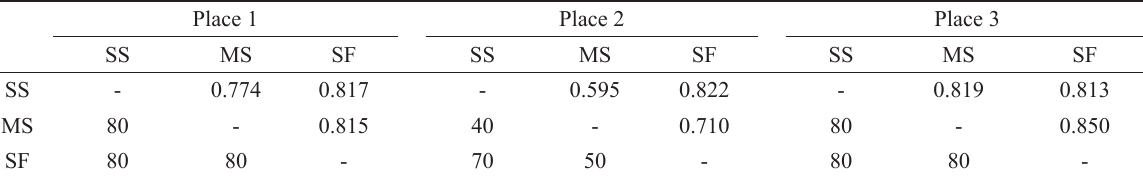
Spearman correlation (above the diagonal) and percentage of coincidence of the top ten families (below the diagonal) between the genetic values of the traits spawning success (SS), multiple spawning (MS) and spawning frequency (SF) of Nile tilapia in three different places in the